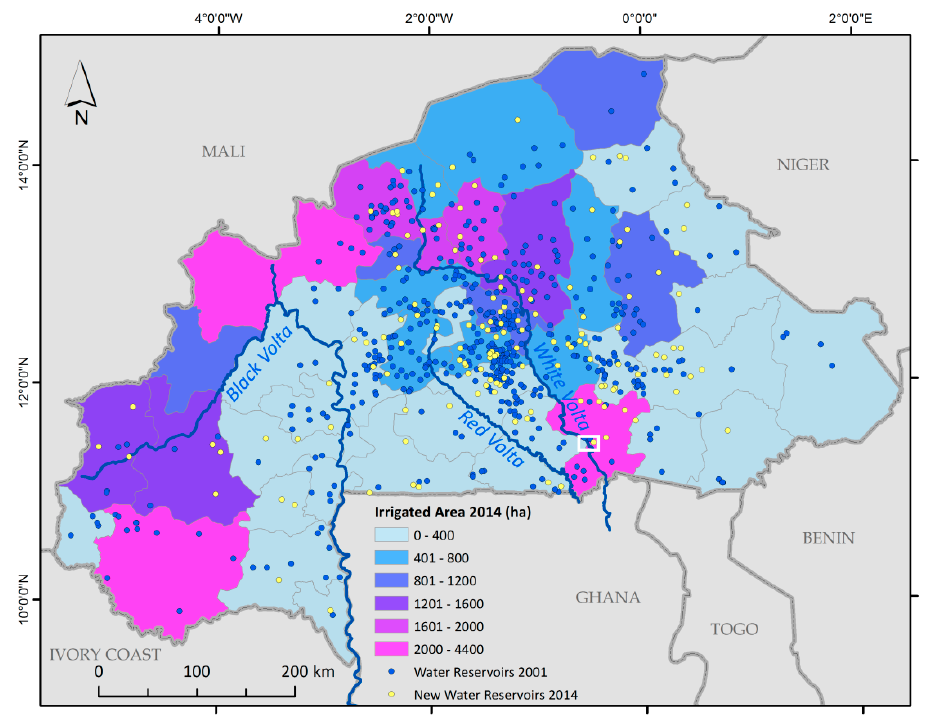
Figure 6. Irrigated area per province for the year 2014 and locations of artificial water reservoirs for the years 2001 and 2014 derived by digitization from the classification results; the white rectangle marks the location of Figure 7.